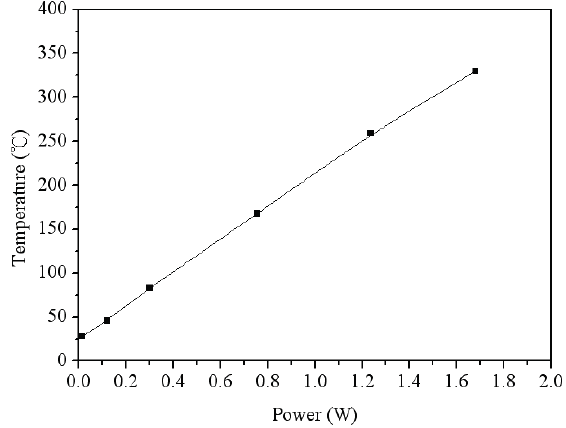
Figure 10. Measured results of heating temperature for the heater.